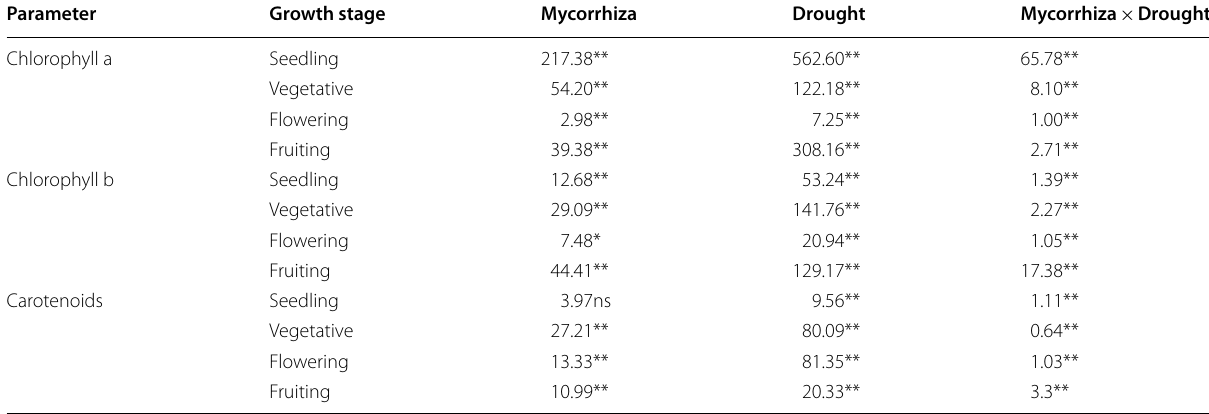
** P < 0.01; * P < 0.05; ns, non‑ significant